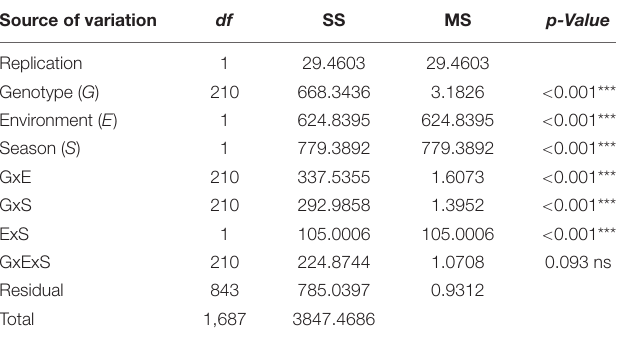
TABLE 1 | Analysis of variance in the collection of common bean genotypes for PM disease.